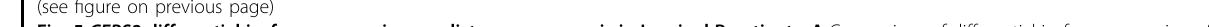
Fig. 5 CERS2 differential isoform expression predict poor prognosis in Luminal B patients. A Comparison of differential isoform expression of CERS2 in tumor ( n = 10) and matched control ( n = 10) breast tissues from Luminal B patients using full-length PC and AS1 transcript speci fi c primers show increased AS1 expression in tumor tissue. A pictorial representation of exon/intron position and primer sites are also shown. B Immuno fl uorescence images and quanti fi cation of CERS2 (mean ± SD, n = 7) show elevated levels in tumor tissue as compared to normal breast tissue sections. C , D Immunoblot showing the expression of proteins corresponding to PC and AS1 transcripts from 4 pairs of Luminal B tumor and adjoining normal tissue samples ( C ), and 12 patient tumor samples ( D ). Protein corresponding to PC transcript is marked by blue asterisk, and to AS1 transcript by red asterisk. E , F Survival Analysis on Luminal B patient data (TCGA-BRCA) using univariate and multivariate Cox proportional hazards (Cox-PH) regression. Inclusion of meta-features (exon 8, fl anking junctions 51135, 51134, 51126 and skipping junctions 51127, 51128) ( E ), in multivariate analysis signi fi cantly affect patient survival ( β coef fi cient = − 229, p < 2e − 16, and C-index = 1) ( F ). Data in A and B were analyzed by two- tailed unpaired Student ’ s t